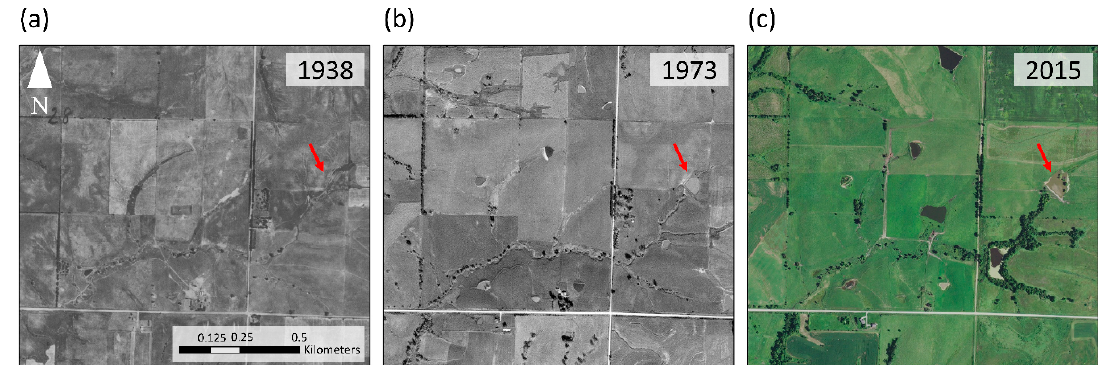
Figure 1. Aerial imagery of farmland in Ringgold County, Iowa depicting the landscape in 1938 ( a ), 1973 ( b ), and 2015 ( c ). Between 1938 and 2015, about nine ponds were constructed in this area. The red arrow indicates a pond that was built after 1938 and then renovated between 1973 and 2015.